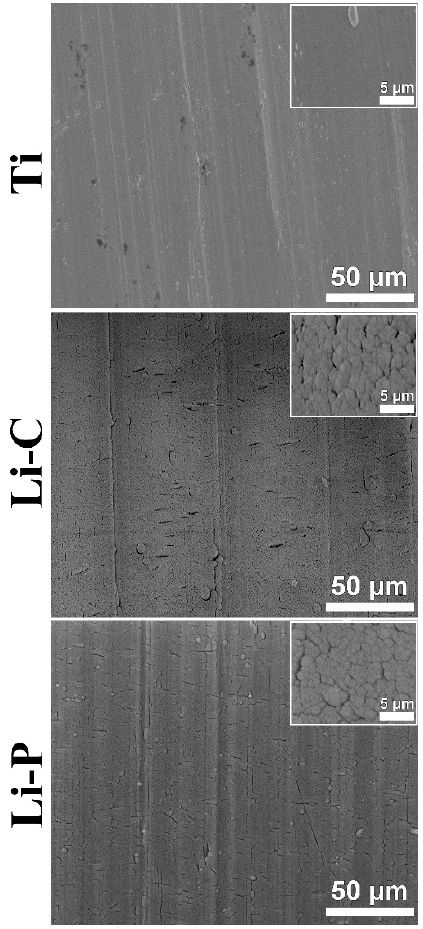
Figure 8. Scanning electron microscopy (SEM) micrographs of control and functionalized (with Li-C and Li-P coatings) 3D Ti implants before implantation.